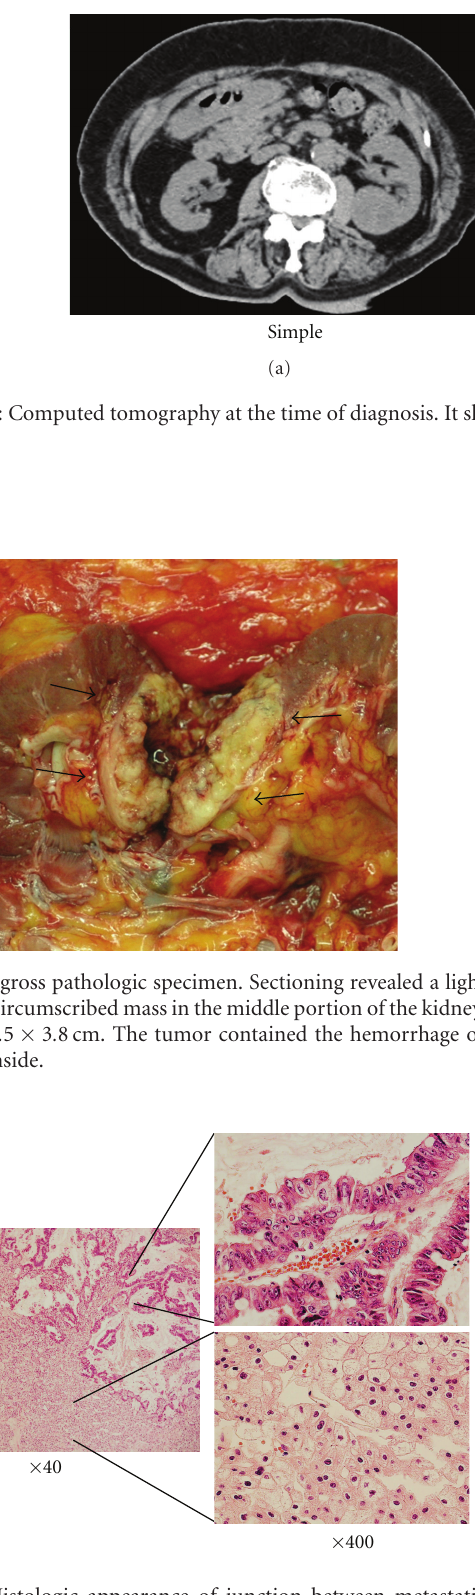
Figure 3: Histologic appearance of junction between metastatic poorly di ff erentiated adenocarcinoma (upper) and chromophobe renal cell carcinoma (lower), HE